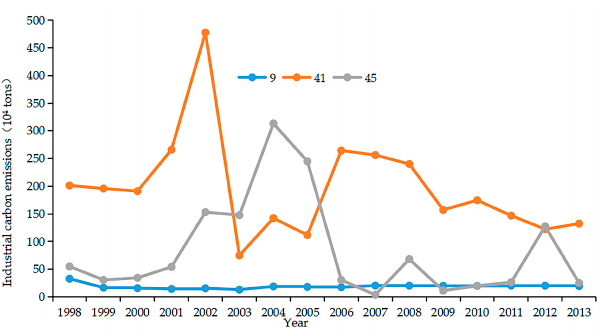
Figure 9. Changes in the Carbon Emissions of the Decrease Type Industries in Guangdong from 1998 to 2013. to